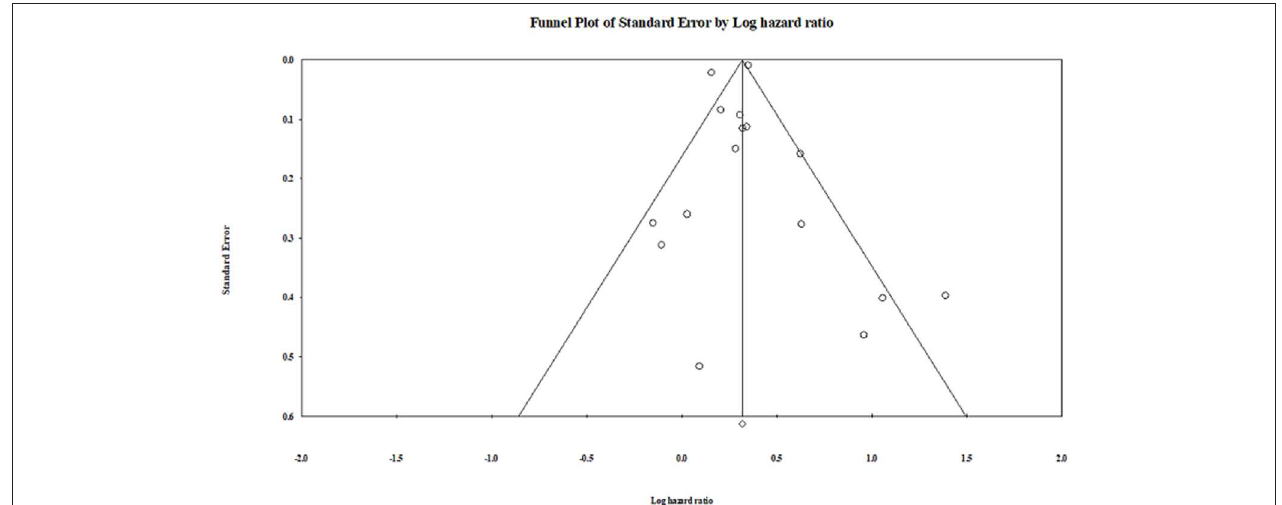
FIGURE 8 | Funnel plot.